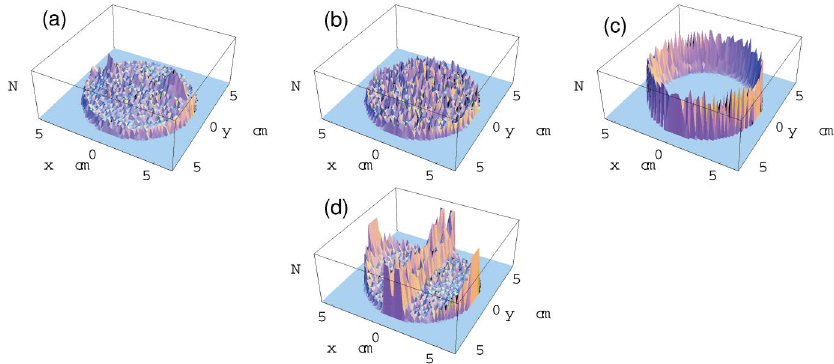
FIG. 2. (Color) Typical electron cloud distribution in the transverse x - y plane. The number of electrons in an arbitrary unit is plotted in the vertical axis. Plots (a) and (b) depict electron distributions in a drift space, where (a) and (b) are for electrons produced mainly at the illuminated position, and produced uniformly, respectively. Plots (c) and (d) depict electron distributions in weak solenoid and strong bending magnets,